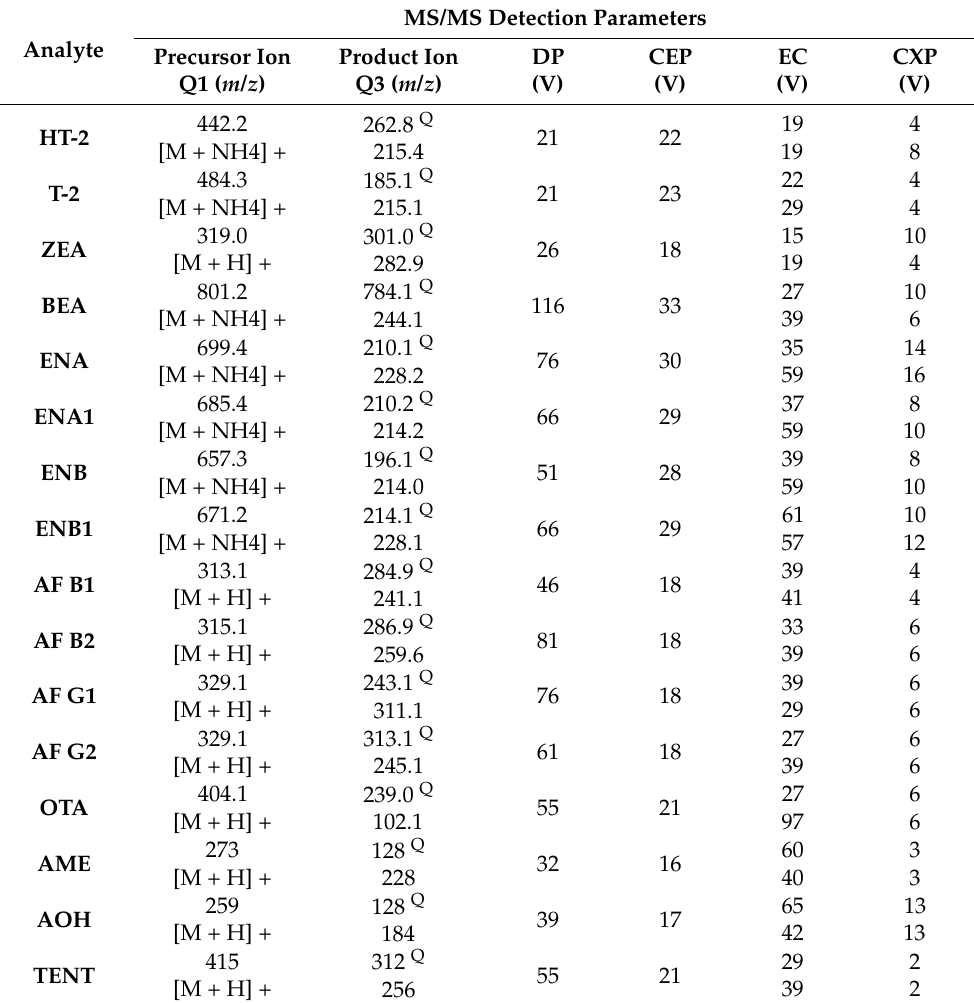
Table 2. MS/MS detection parameters for the analysis of the studied